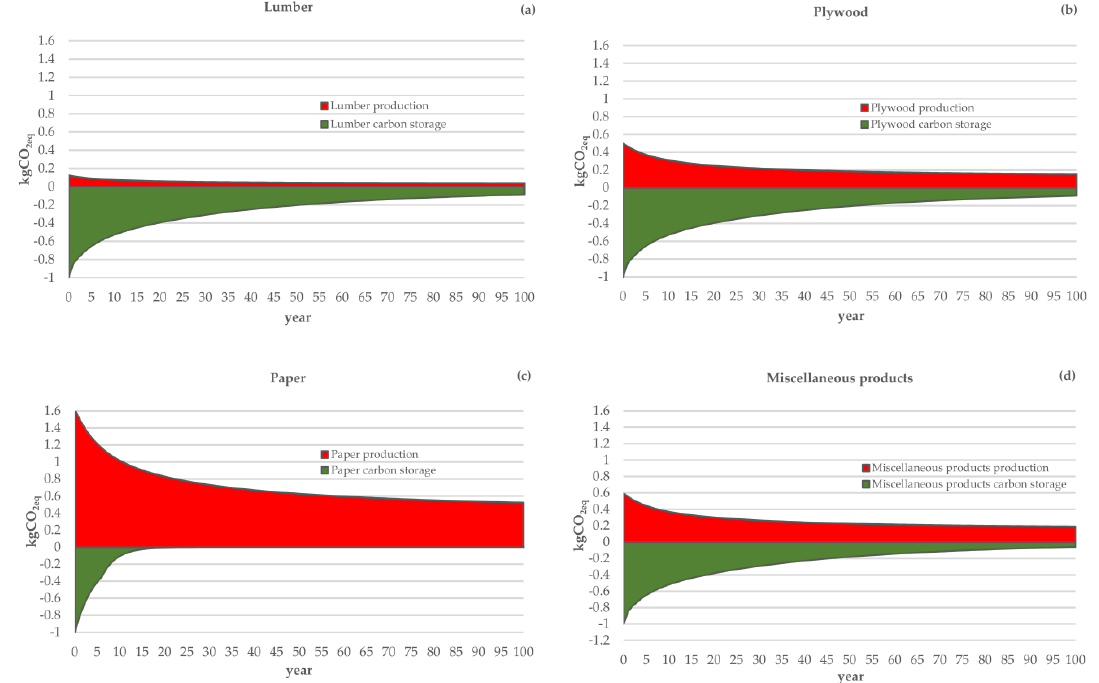
Figure 3. Comparison between the CO 2 decay from wood products manufacturing fossil fuel-based life cycle emissions (red), and avoided CO 2 decay from wood products carbon storage (green), for 1 kg of ( a ) softwood lumber; ( b ) softwood plywood; ( c ) paper products; ( d ) miscellaneous products (particle boards and roundwood from lumber production sold off-site). The time horizon of the evaluation is 100 years.